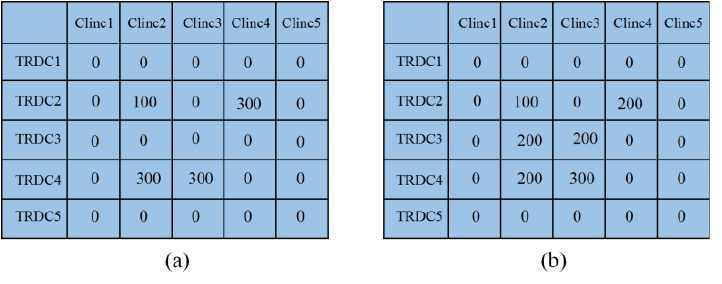
Figure 3. An encoded chromosome for relief planning.